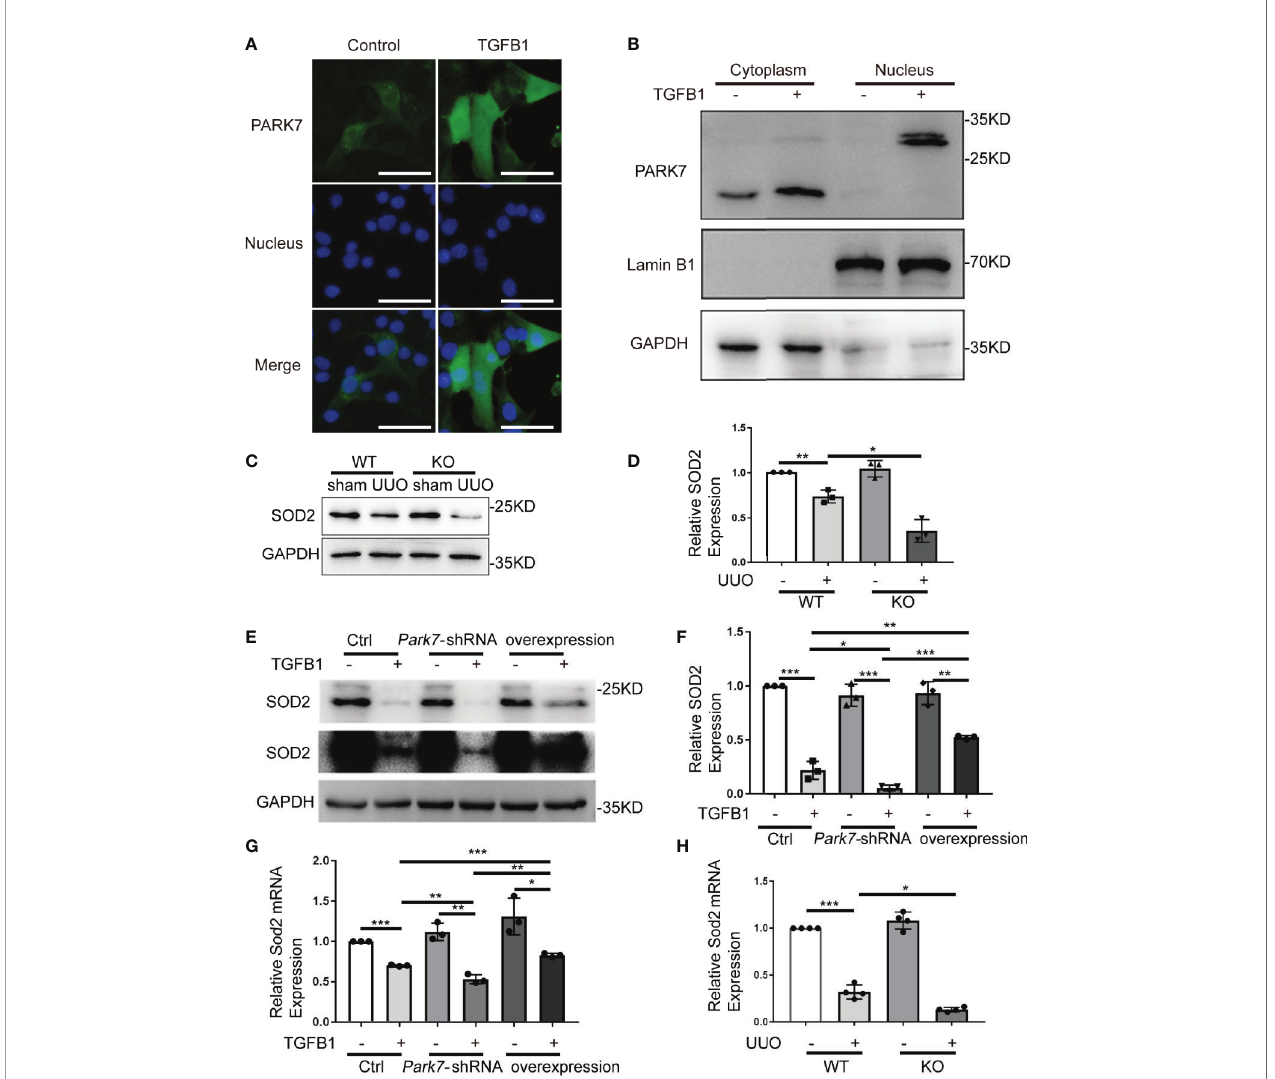
FIGURE 9 | PARK7 translocates into nucleus and positively regulates SOD2 expression during renal fi brosis. (A, B) BUMPT cells were cultured in medium with/ without 5 ng/ml TGFB1 for 24 hours. (A) Representative images of immuno fl uorescence staining of PARK7 in BUMPT cells. Bar:50 m m. (B) Representative immunoblot of PARK7, LaminB1 (nuclear marker), and GAPDH (cytosolic marker) in cytosolic and nuclear fractions. (C, D) Animals and their treatment were the same as described in Figure 2 . (C) Representative immunoblot of SOD2 and GAPDH. (D) Densitometry of SOD2 signals (n=4). (E, F) BUMPT cells were transfected with Park7 siRNA or PARK7 overexpression plasmid. 24 hours after transfection, the cells were cultured in medium with or without 5 ng/ml TGFB1 for another 24 hours. (E) Representative immunoblot of SOD2 and GAPDH. (F) Densitometry of SOD2 signals (n=3). The signal of SOD2 was normalized to the GAPDH signal of the same samples to determine the ratios. The values are expressed as fold change over control cells. (G, H) Sod2 mRNA expression. Each symbol (circle, diamond and trigon) represents an independent experiment or an individual mouse. Error bars: SEM. *p < 0.05, **p < 0.01, ***p <